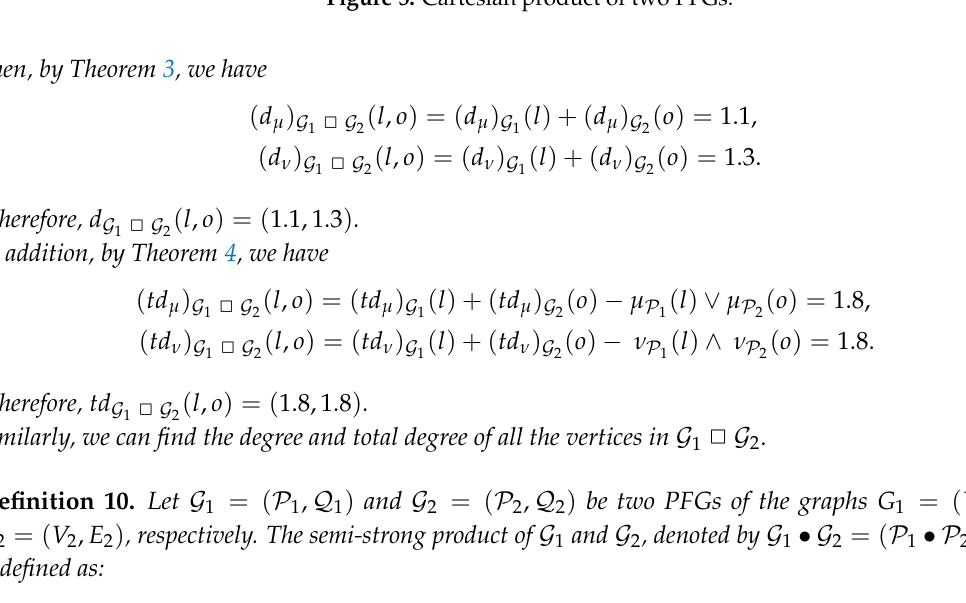
Figure 5. Cartesian product of two